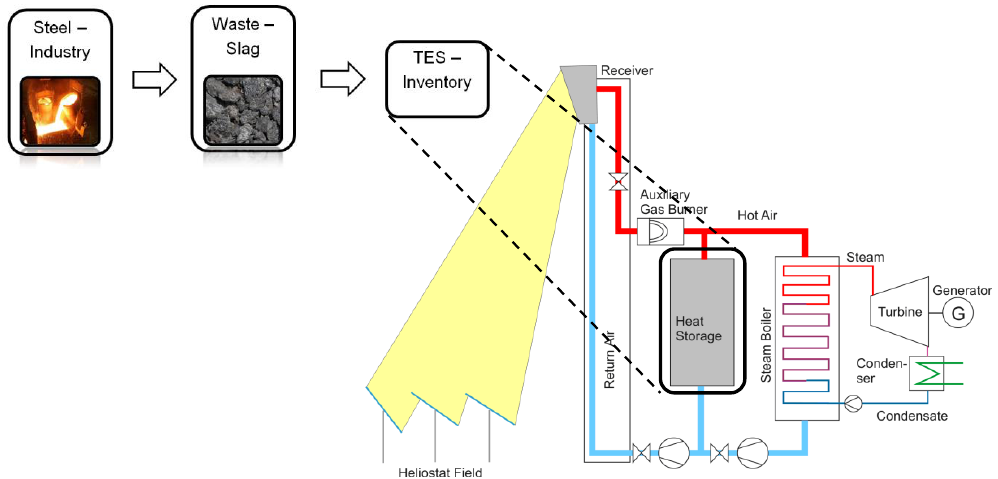
Figure 1. Flow sheet of a concentrated solar power (CSP) plant with a thermal energy storage based on slag inventory [22].